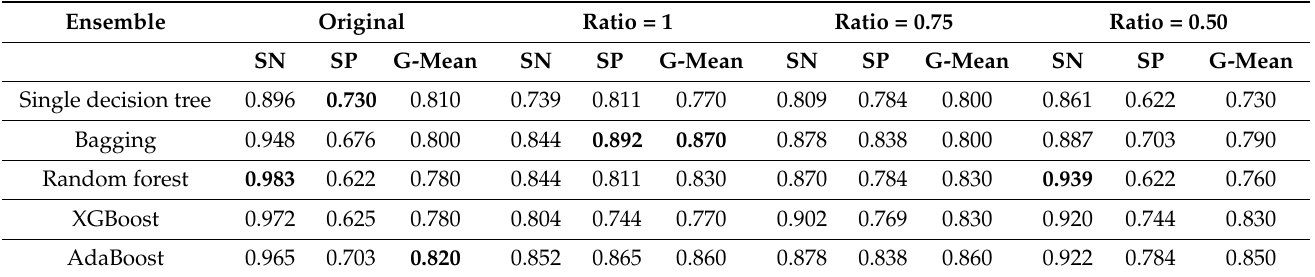
Table 7. The performance metric of ensembles (standard decision tree) along with the undersampling method of minority and majority class points for different ratios SN, SP, and G-Mean performance metrics are considered for this experiment. (Bold numbers show the best